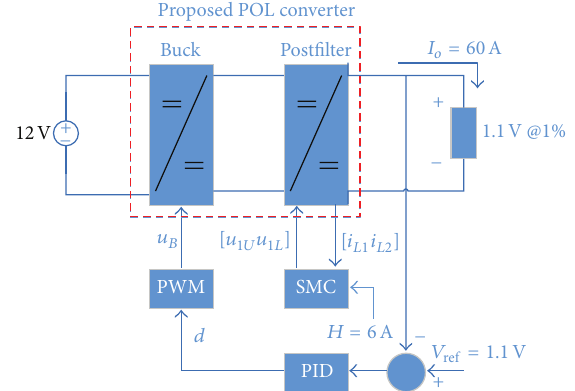
Figure 8: Practical implementation of the proposed Core 2 Duo POL